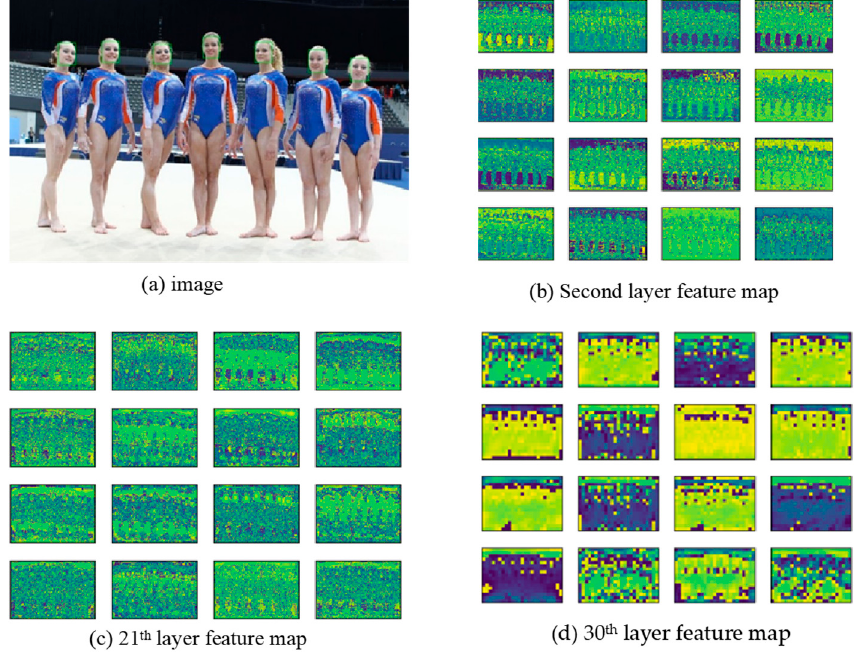
Figure 3. Shallow features and deep features (( a ) is the input image with labels, ( b ) is the feature map of the second layer of feature extraction, ( c ) is the feature map of the 21st layer in the feature extractor, and ( d ) is the feature map of the 30th layer of feature extraction).